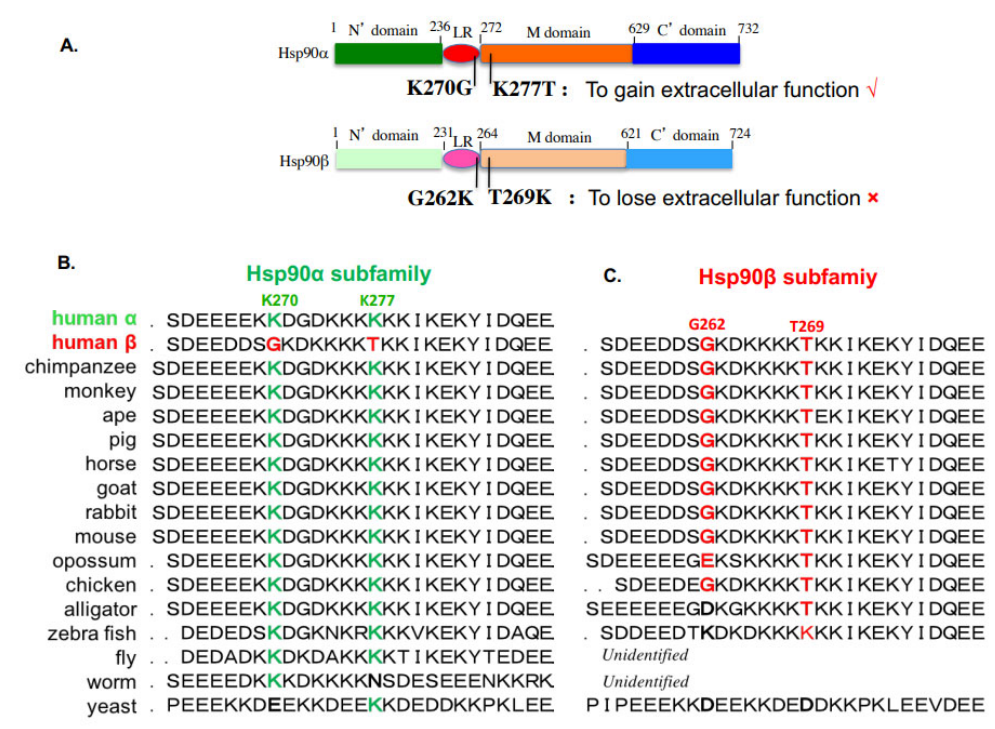
Figure 2. Evolutionarily conserved lys-270 and lys-277 distinguish Hsp90 α from Hsp90 β for having important extracellular functions. ( A ) The dual lysine motif is essential for the extracellular and ATPase ‐ independent functions of eHsp90 α . Substitutions of G262 and T269 in Hsp90 β with lysine grant Hsp90 β similar extracellular functions to eHsp90 α . The dual K270/K277 motif in human Hsp90 α ( B ) and the corresponding G262/T260 motif in human Hsp90 β ( C ) are evolutionarily conserved in all the Hsp90 α subfamily and the Hsp90 β subfamily members, respectively.